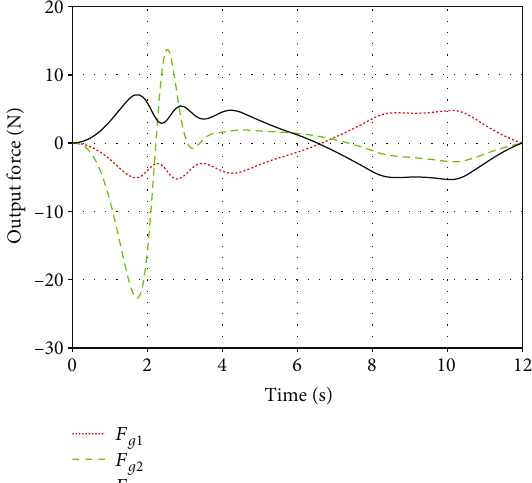
Figure 6: Joint angles.